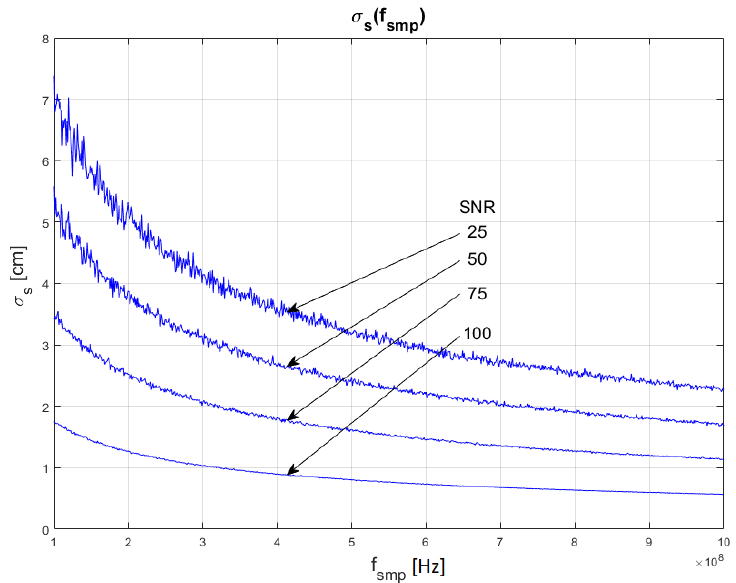
Figure 7. Dependence of measurement uncertainty on sampling frequency f smp . Parameters of generated pulses are shown in Table 2 Block 4.